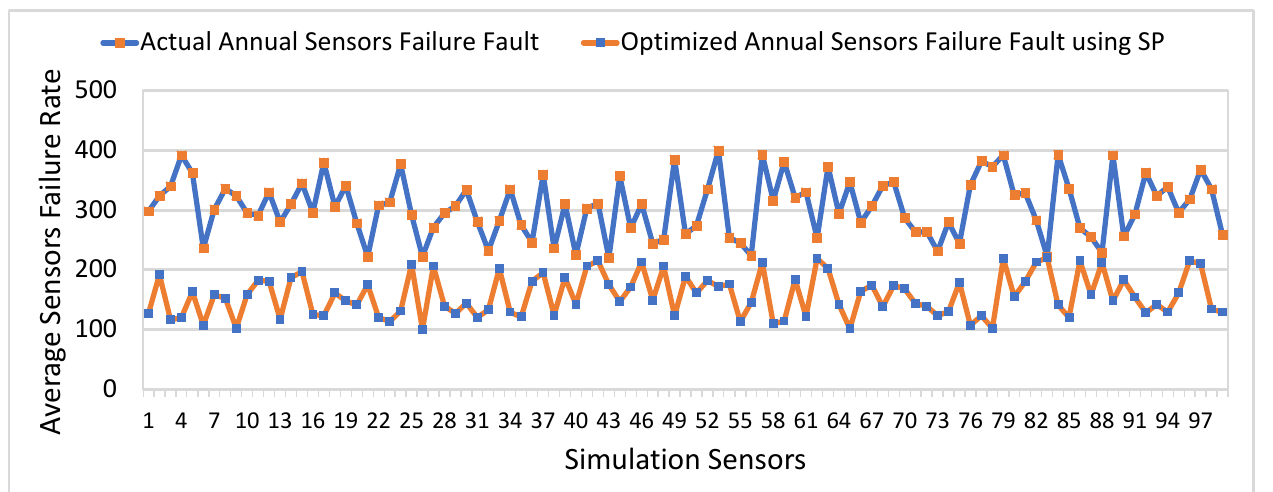
Figure 13. Comparative Analysis of Actual and Optimized Sensors Failure Frequency